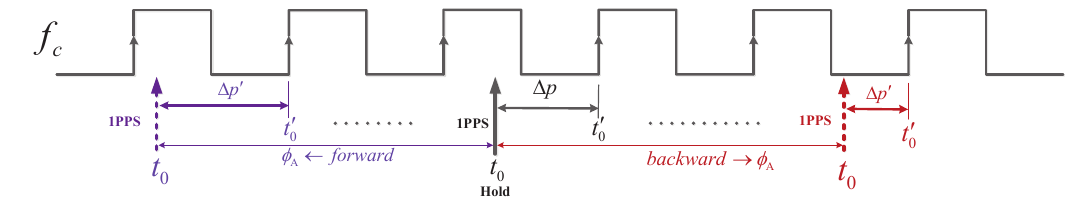
Figure 2. Uncertainty of the ∆ p between t 0 and t (cid:48) 0 with the